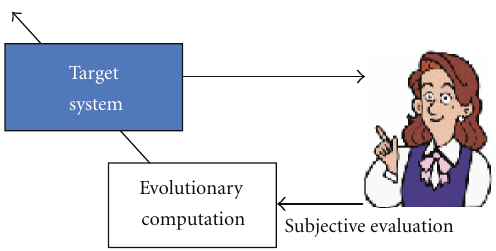
Figure 2: Human factors became important in conventional engineering.